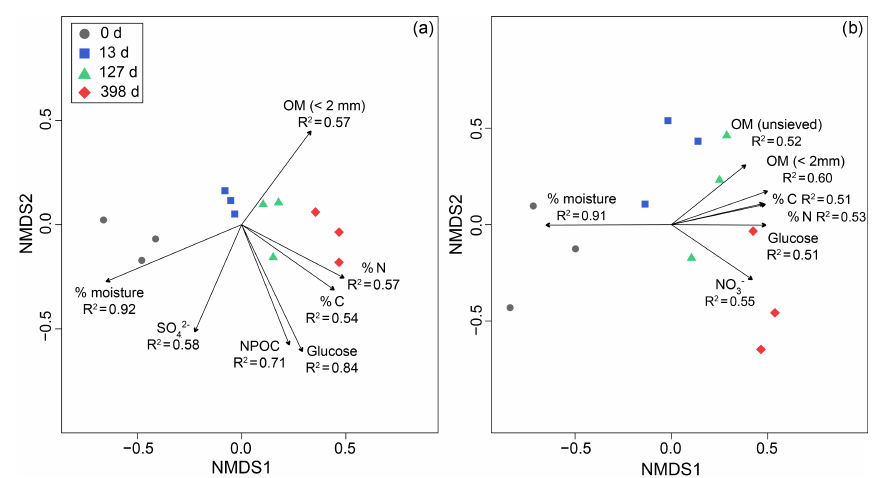
Figure 3. Non-metric multidimensional scaling (NMDS) plots of bacteria/archaea (a) and fungi (b) community composition ( n = 12). Colors indicate groupings by days since inundation, which are significantly different (PERMANOVA, bacteria/archaea: P < 0 . 001; fungi: P < 0 . 01). Vectors indicate significant environmental variables with corresponding R 2 values. Table 1. Mean, standard deviation (SD), significance ( P ), and R 2 values (n.s. if not significant) from linear regressions of environmental variables and the log of days since inundation from untreated sediment ( n = 12). Organic matter (<2mm) also had a significant quadratic